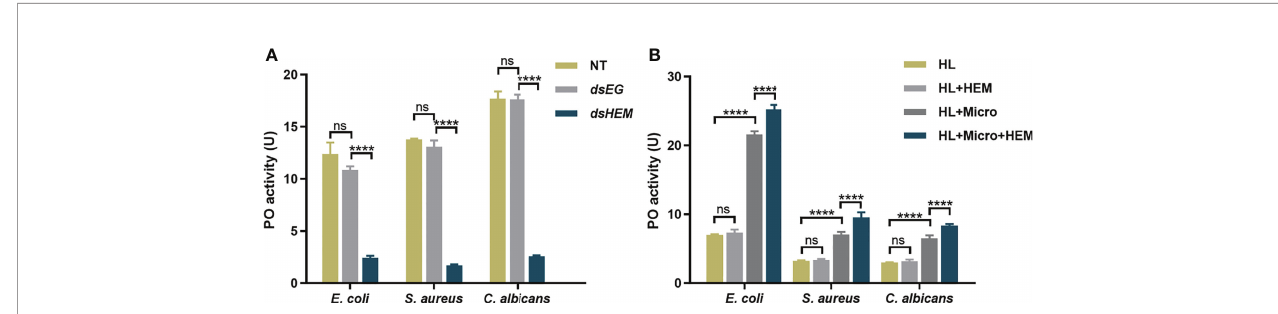
FIGURE 5 | PO activity assay triggered by microbes. (A) The effects of endogenous hemolin on PPO cascade activation by microbes were investigated by monitoring the PO activity produced in hemolin knockdown plasma. Hemocyte-free plasma of 2 nd instar larvae was collected 24 hr after dsRNA injection. Then, the PO activity triggered by microbes was examined. dsEG and dsHEM : plasma samples from dsEGFP - and dshemolin -injected 2 nd instar larvae, respectively; NT: nontreated 2 nd instar larvae plasma. (B) The effects of exogenous hemolin on PPO activation stimulated by microbes were investigated with recombinant hemolin and 5 th instar native larvae plasma. HL: native cell-free hemolymph (total protein: 12 mg/ml); HEM: recombinant His 6 - Ap -hemolin (500 ng); Micro: E. coli, S. aureus and C. albicans (5 × 10 2 cells per sample). Each bar represents the mean ± SD (N=3). ****: p<0.0001, ns, no signi fi cant difference.